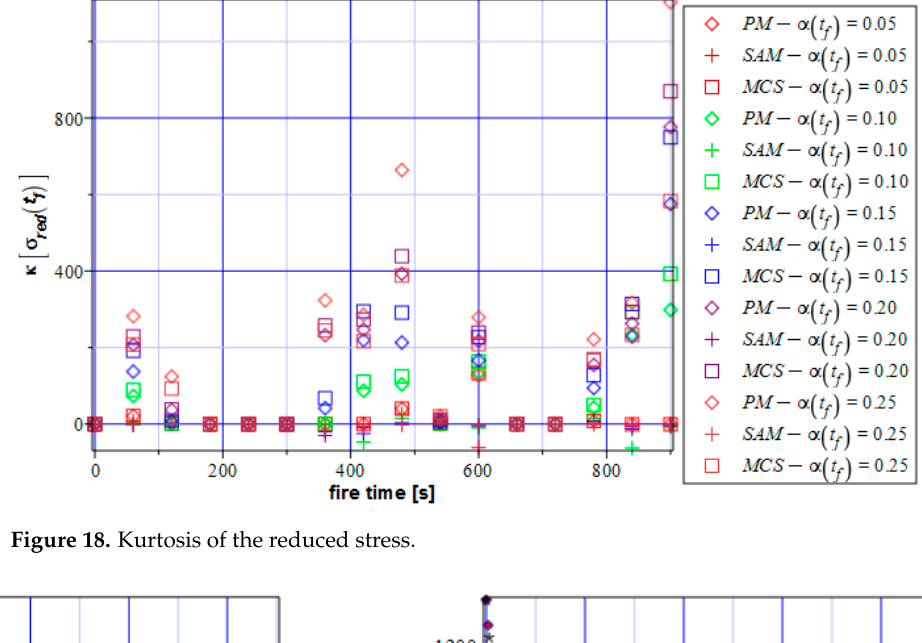
Figure 17. The skewness of the reduced stress.